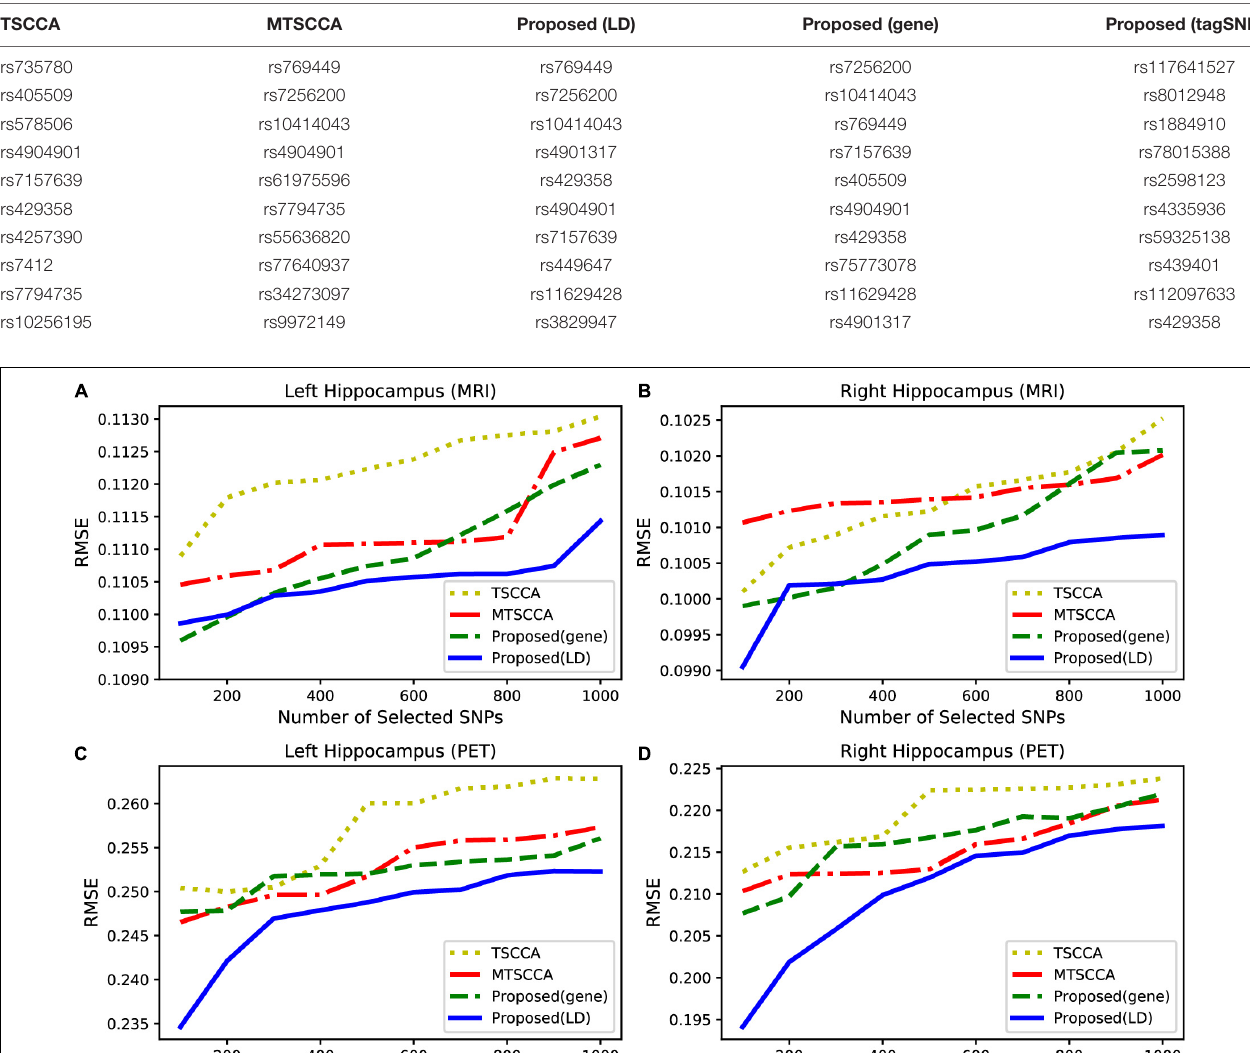
TABLE 5 | The top ten selected SNPs. TSCCA